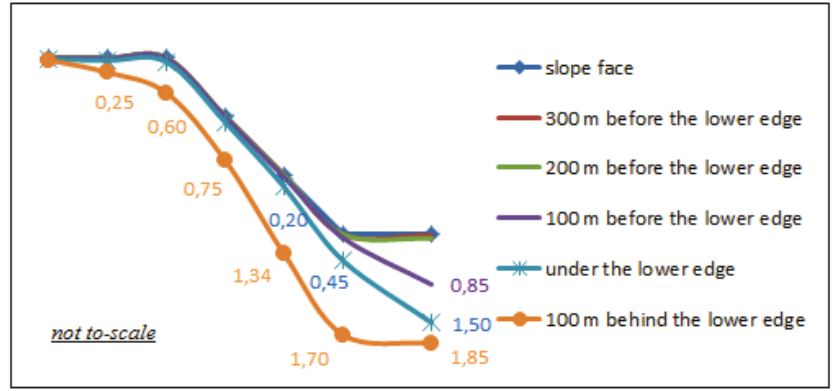
Fig. 17. Vertical displacement of slope face when the longwall operation proceeds from the right side toward the lower edge of slope (measured point is the face of the longwall panel)